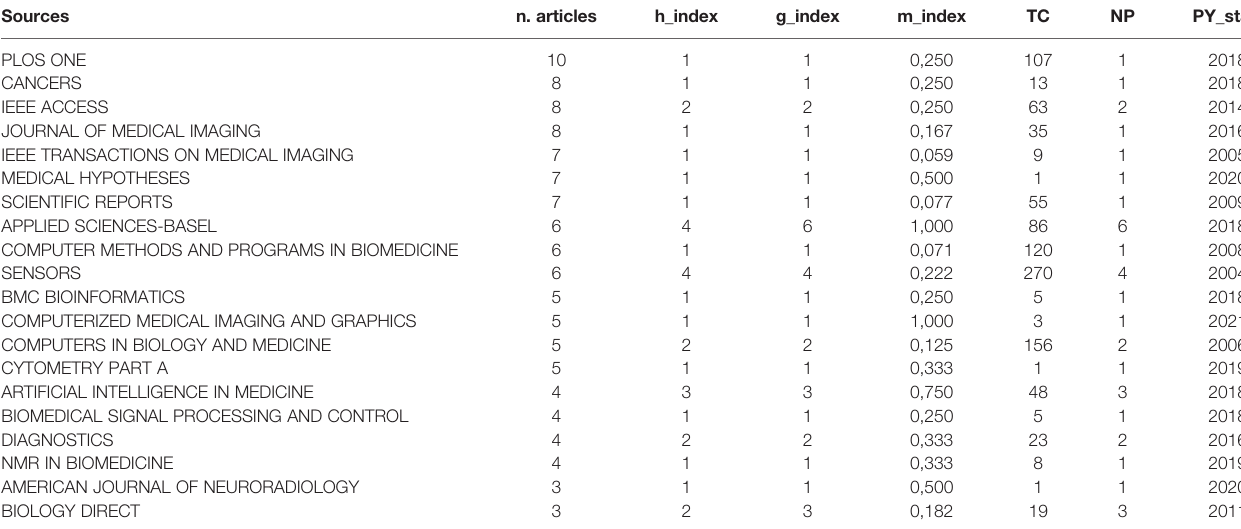
TheTableincludesthe fi rst20journalsinorderofnumberofpublications.H-index:TheHirschindex(H-index)isajournal ’ snumberofpublishedarticles(h),eachofwhichhasbeencitedin other papersat least h time(s).m-index: Them-index is de fi ned as H/n, where H isthe H-index and n isthe number ofyears since the fi rst published paper ofthe journal. Theg-index is